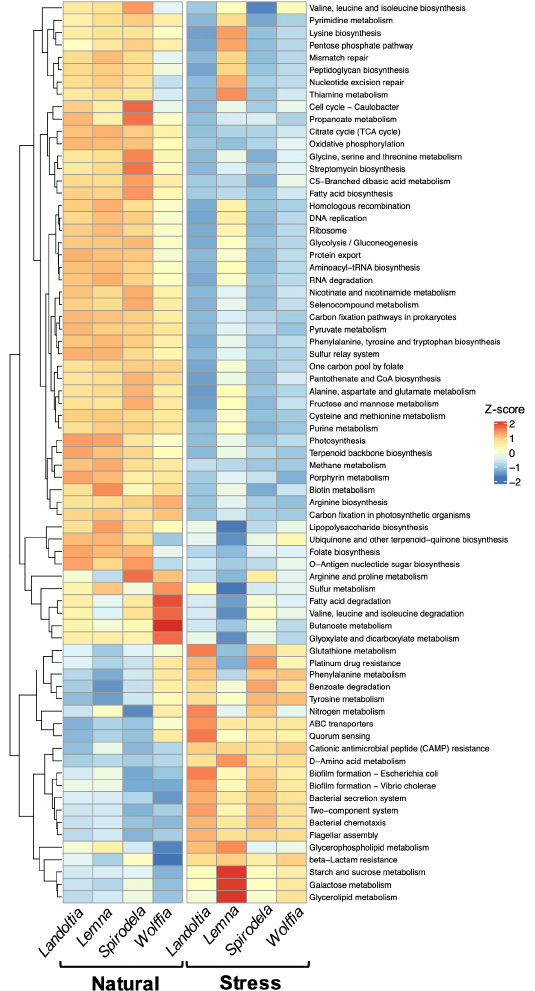
Figure 6. Functional prediction of bacterial communities of duckweeds predicted by PICRUSt2. Relative abundance of pathways that are significantly different ( p -value < 0.05) between natural and stressed duckweeds are